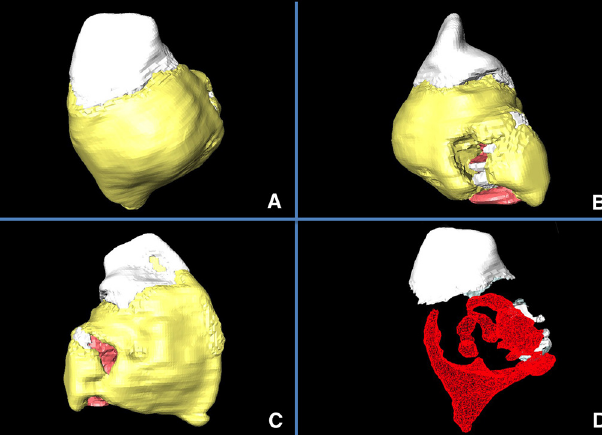
Fig. 3. Reconstructed 3D CBCT images of the fi nal volume of the dilated odontoma in 16-bit. Each type of tissue was characterized by a color. The enamel-like mineralized tissue was colored in white, the cement-like structure was in yellow whereas the non-mineralized pulp- tissue was in red. (A) Labial view. (B) Mesial view. (C) Lingual view. (D) Internal view showing the complex anatomy of the pulpal canal and enamel invagination (in